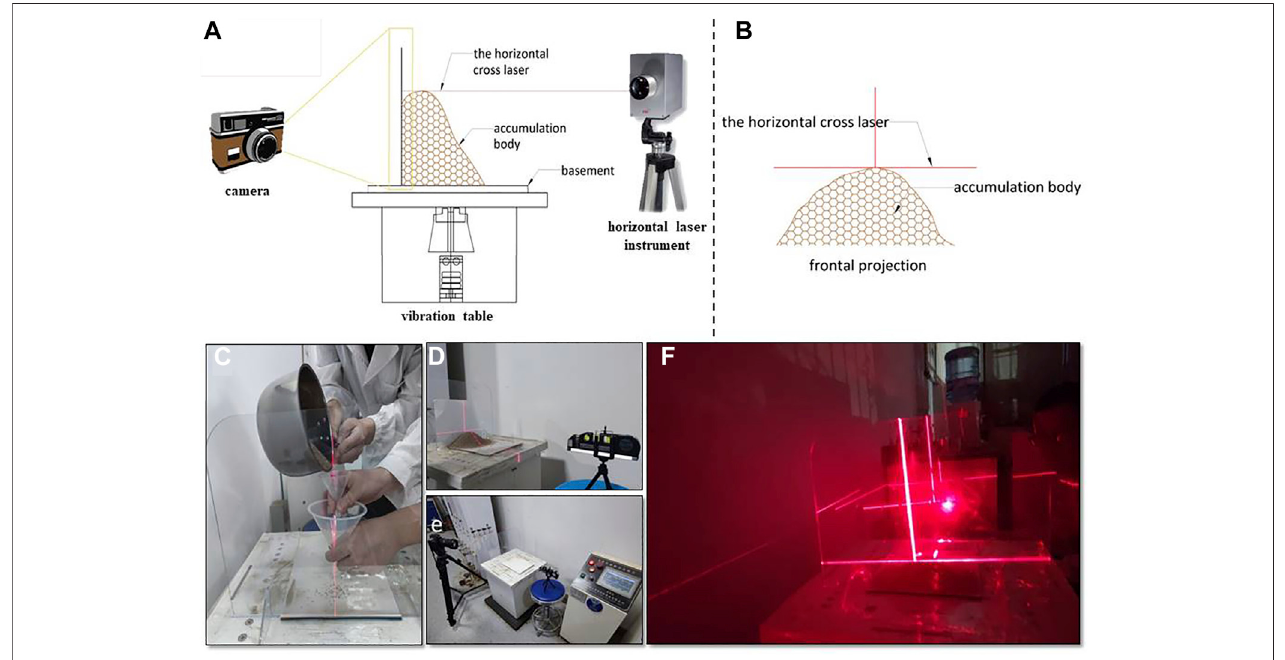
FIGURE5|(A) Fixed funnel method principle. (B) Frontal projectionoflasermeasurement. (C) Fixedfunnel method. (D) Measure theangle withlaser. (E) Vibration table (F) Cross laser penetrating the accumulation